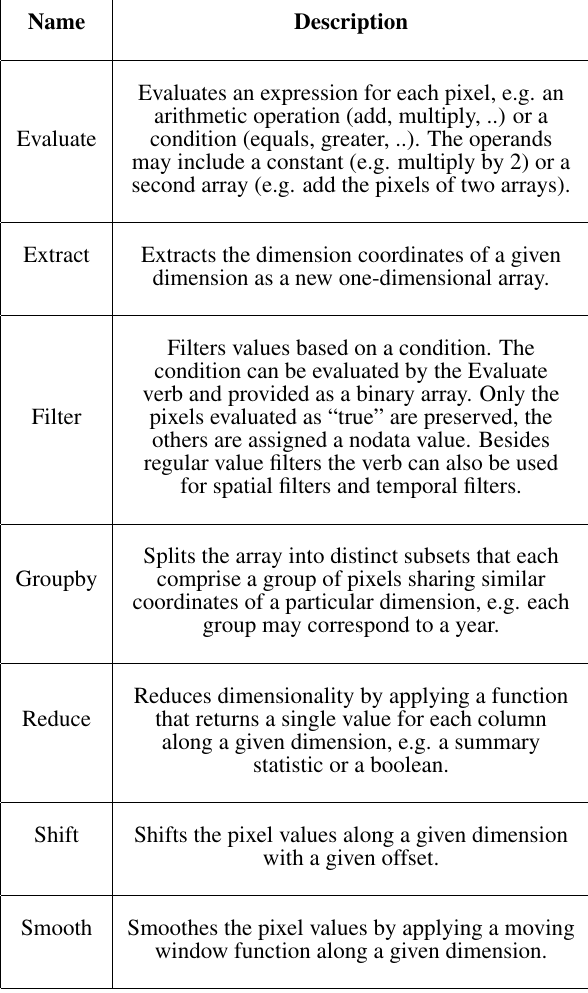
Table 1. Verbs for semantic arrays.